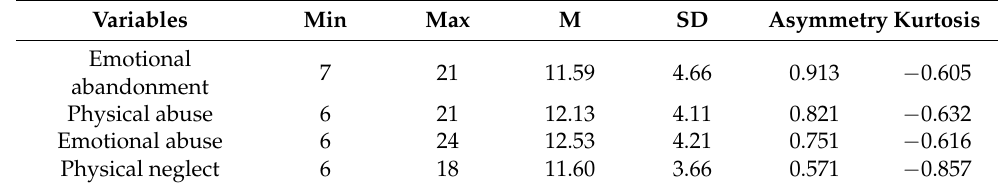
Table 4. Descriptive statistics for the types of abuse (n = 425). Variables